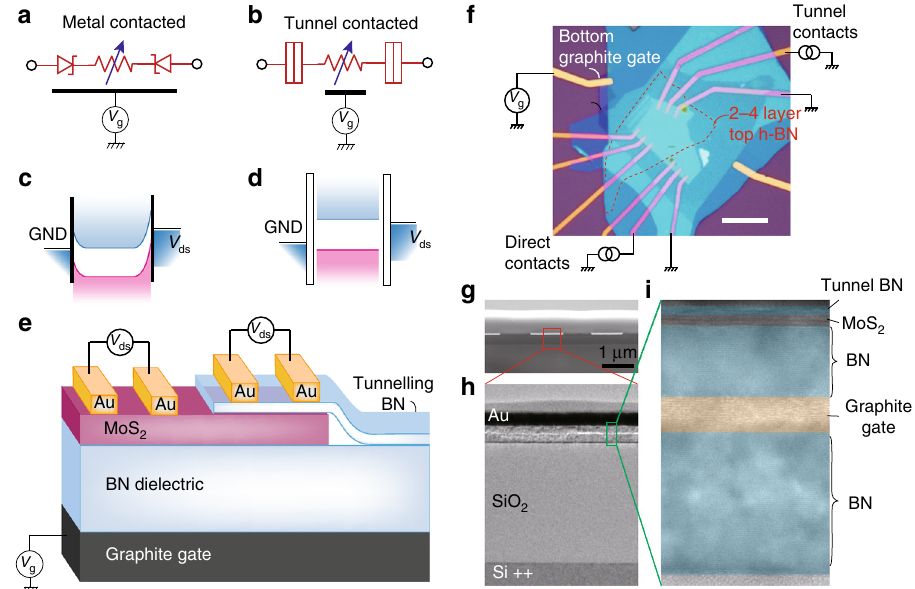
Fig. 1 Comparison between metal-contacted and metal/insulator tunnel-contacted MoS 2 FETs. a Schematics of a metal-contacted MoS 2 fi lm leading to a Schottky barrier fi eld effect transistor (SB-FET). b Schematics of a tunnel-contacted MoS 2 fi eld effect transistor (TC-FET). c , d Semiconductor representation of the energy levels respectively for SB-FET and TC-FET showing the absence of band bending in TC-FETs. e Schematics cross section of the device showing SB-FET and TC-FET side by side on the same MoS 2 fl ake. f Optical micrograph of a typical TC-FET device. Red dashed line highlights the two to four layer tunnel top h-BN, which covers half the MoS 2 . Scale bar is 10 μ m. g Scanning electron microscopy (SEM) image of the cross-section of the graphite-gated MoS 2 vertical tunnel device, with its boxed area zoomed in transmission electron microscopy (TEM) images in h ,